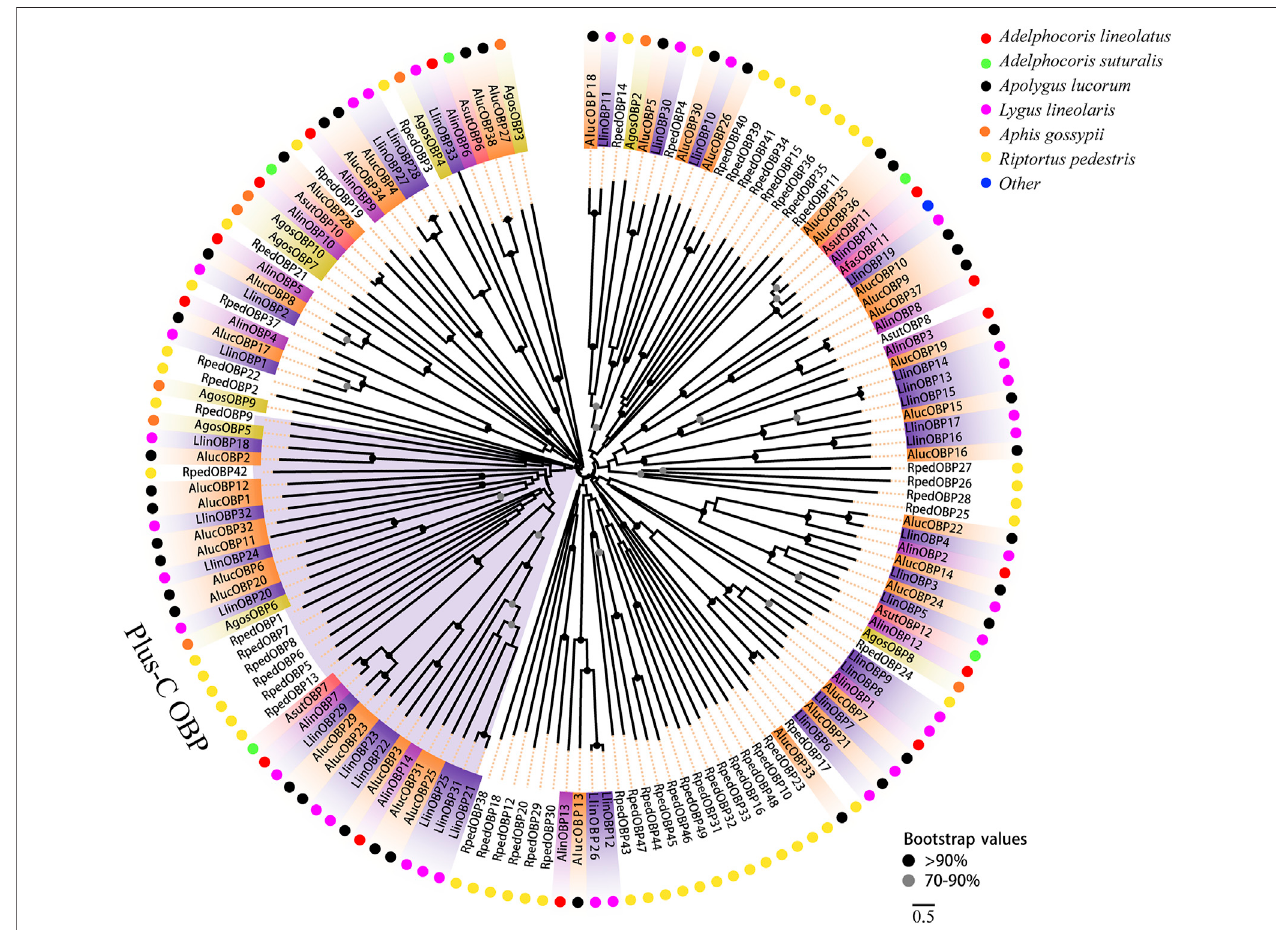
FIGURE 4 | Phylogenetic tree of OBPs. Phylogenetic neighbor-joining tree was constructed using MEGA7 based on alignment results of MEGA7. A phylogenetic neighbor-joining tree was constructed using the OBPs protein that removed signal peptide. Bootstrap values higher than 70 were displayed.